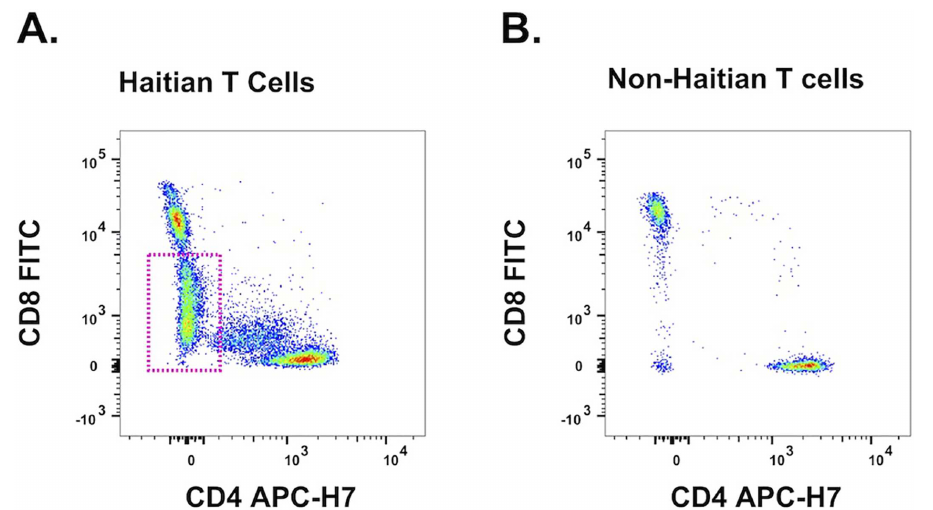
Fig 3. CD8 mid T cells are a unique haitian leukocyte population. PBMCs from all Haitianpatients (n = 15) displayeda uniqueCD3 + CD8 + T cell population,which expressed CD8, called CD8 mid T cells, at lower levels than non-Haitian individuals. (A) A representative flow cytometry dot plot of the CD4/CD8 axis of CD3+ T cells. The CD8 mid populationof T cells is highlightedin pink. (B) Representative CD4/CD8 axis plot of PBMCs from individualsof non-Haitian origin (n = 4), stainedduringthe same experiment, using the same reagents. The CD8 mid population is conspicuouslyabsent.